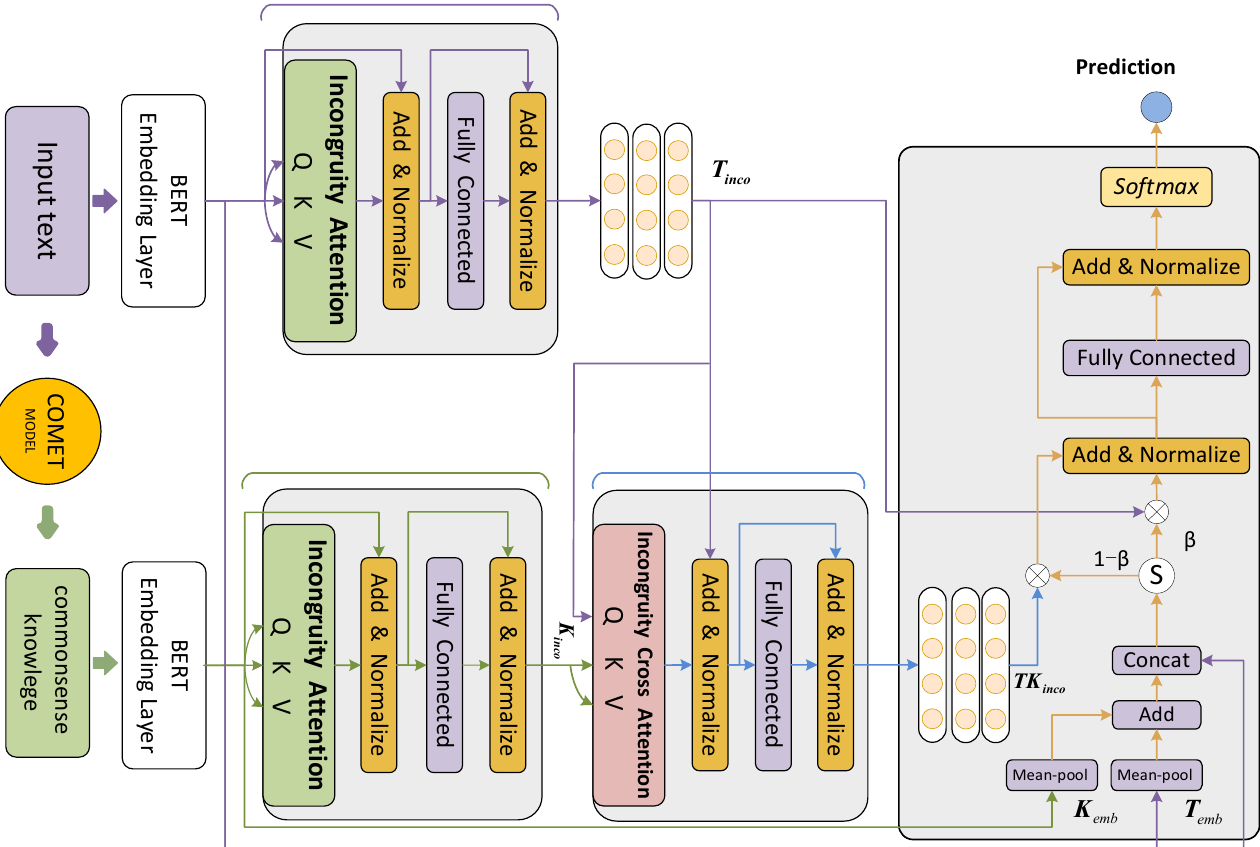
Figure 2. The structure of our proposed model.